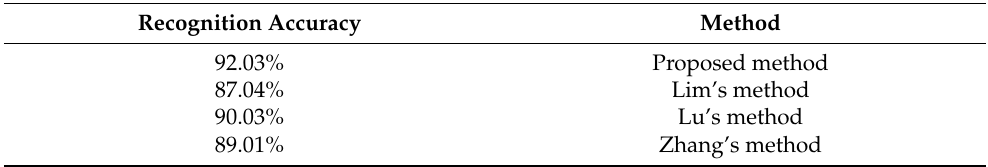
Table 6. The average recognition accuracy of these methods in test set.